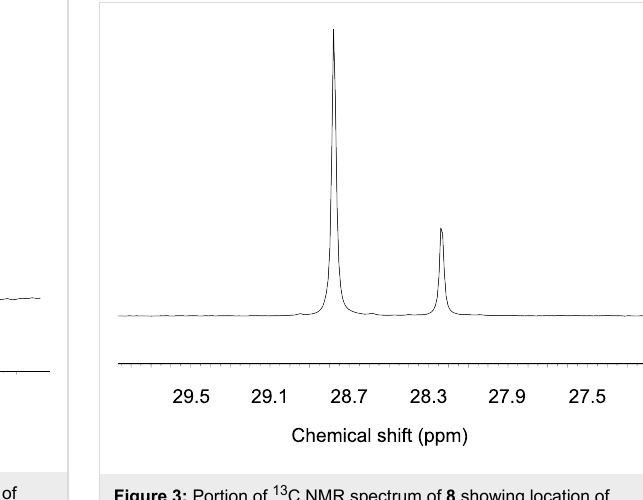
Figure 3: Portion of 13 C NMR spectrum of 8 showing location of 13 C label in the less shielded methyl group.